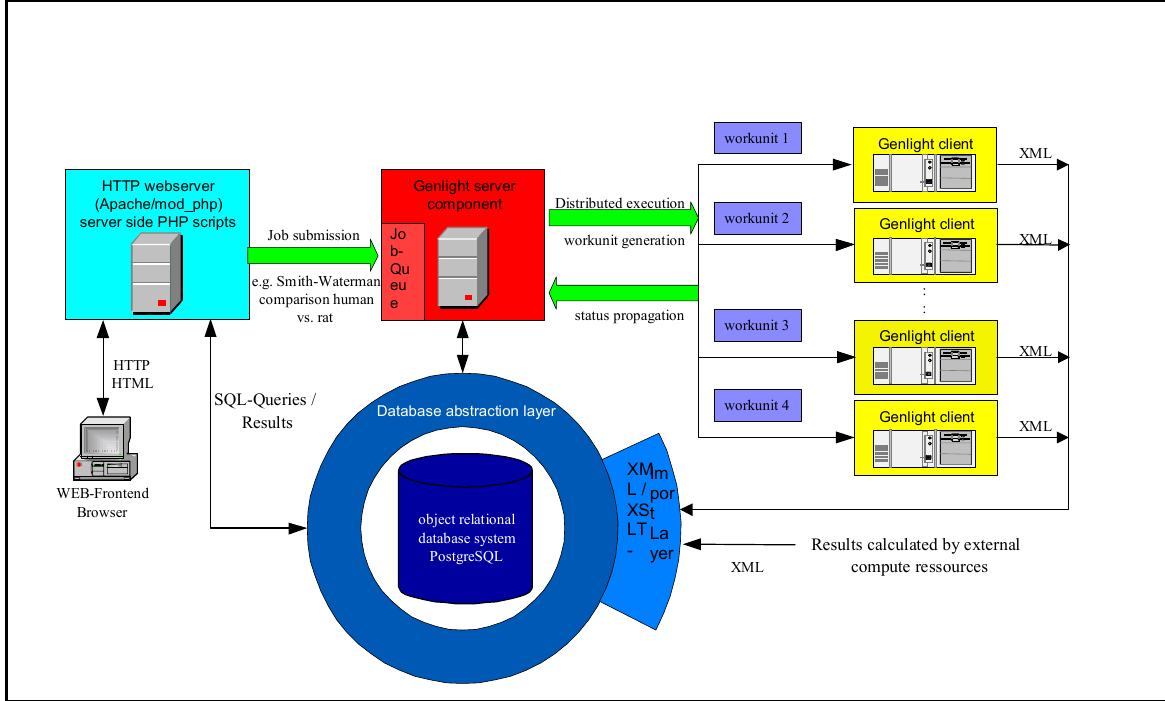
Figure 1: A schematic view of the Genlight system